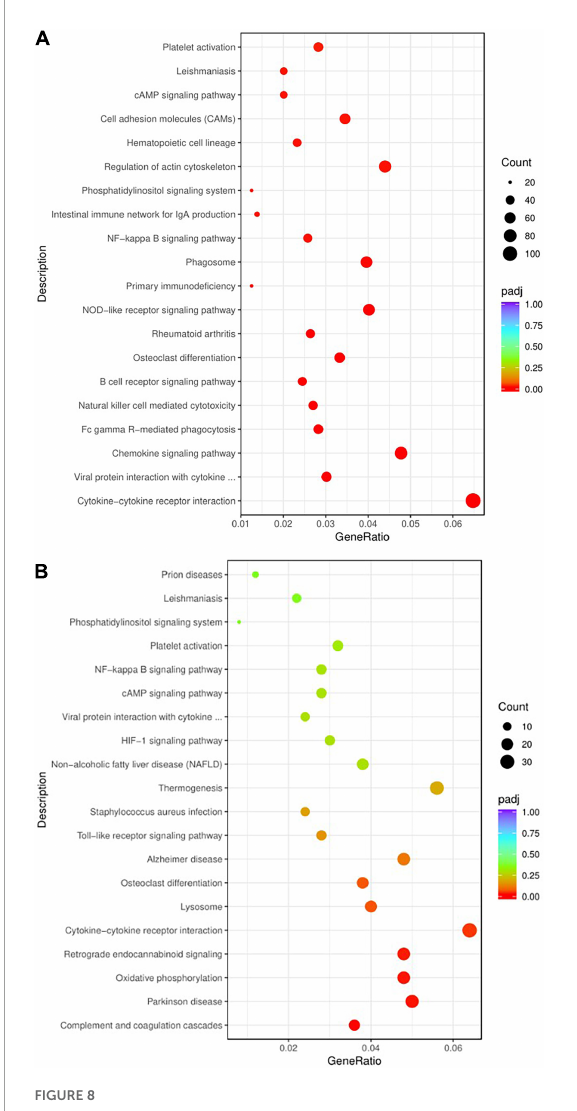
FIGURE8 The bubble chart of KEGG enrichment analysis. (A) KEGG enrichment analysis bubble chart of Pmodel/sham. (B) KEGG enrichment analysis bubble chart of Pmodel/EA. The Y -axis represents the pathway name, and the X -axis represents the enrichment factor, that is the ratio of the amount of DEG enriched in the KEGG term to the total amount of differential genes. The greater the ratio, the greater the degree of enrichment. The size of the bubble indicates the number of genes in this pathway, and the color of the bubble from red to purple represents the significance of